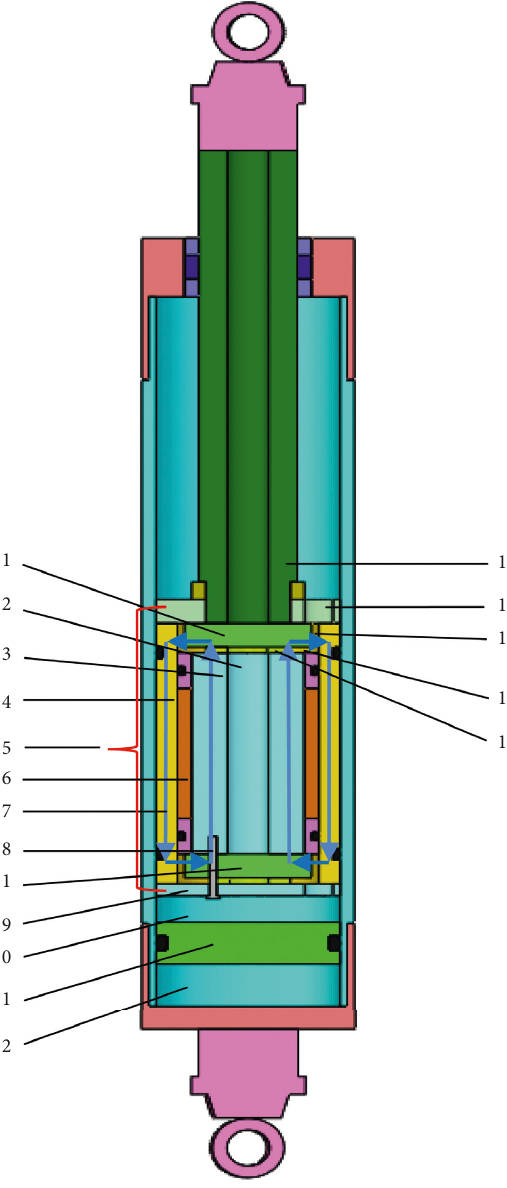
Figure 38: The 3D drawing of annular radial-duct MR damper: 1, circular disk; 2, central hole of core; 3, core; 4, core cylinder; 5, piston unit; 6, exciting coil; 7, magnetic flux; 8, positioning pin; 9, positioning disk; 10, MRF; 11, floating piston; 12, accumulator; 13, washer; 14, radial duct; 15, annular duct; 16, diversion hole; 17, piston rod